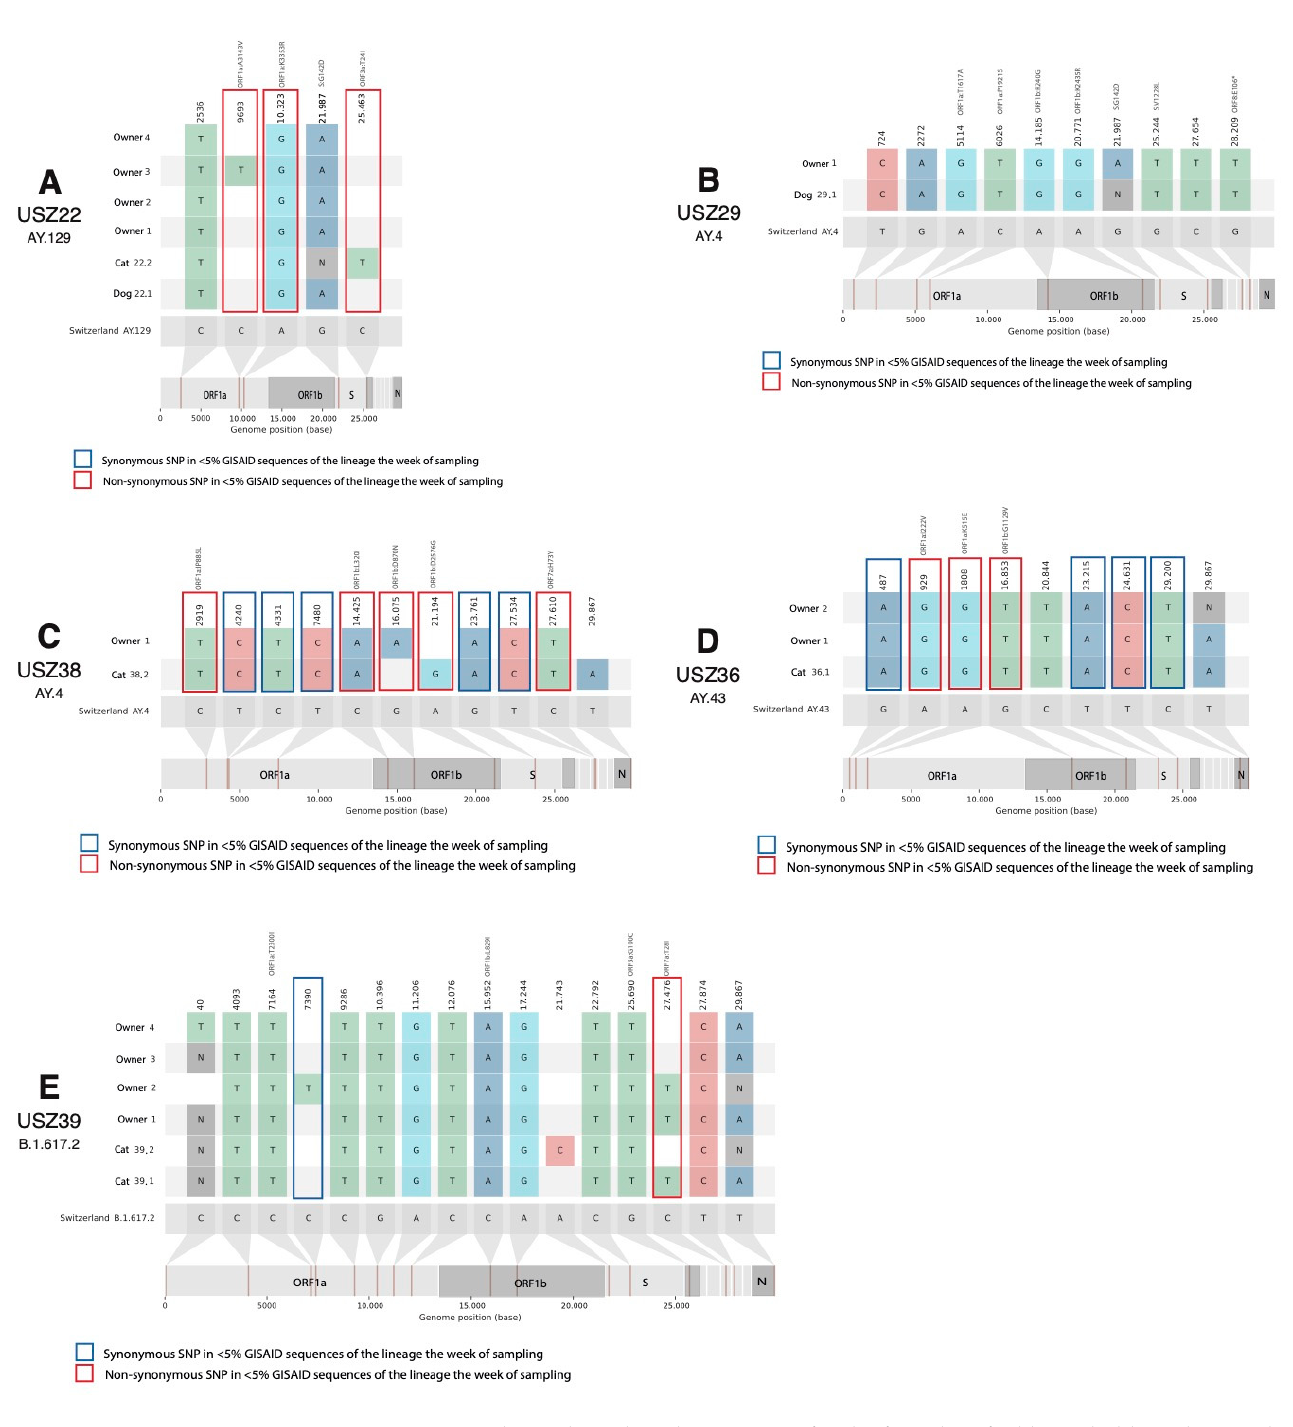
Figure 4. Snipit plot with nucleotide mutations for the five identified households with NGS data. Only mutated positions that are not common for the designated lineage (<75% GISAID sequences of the lineage) are shown. Mutations that are shared by less than 5% of the identified lineage (AY.129 for A , AY.4 for B , C , AY.43 for D , and B.1.617.2 for E ) sequences in Switzerland in the week of sampling are indicated with a box: red for non-synonymous SNPs and blue for synonymous SNPs. ( A ) household USZ22, ( B ) household USZ29, ( C ) household USZ38, ( D ) household USZ36, and ( E ) household USZ39. Amino acid substitutions are indicated in gray on top of the non-synonymous mutations.